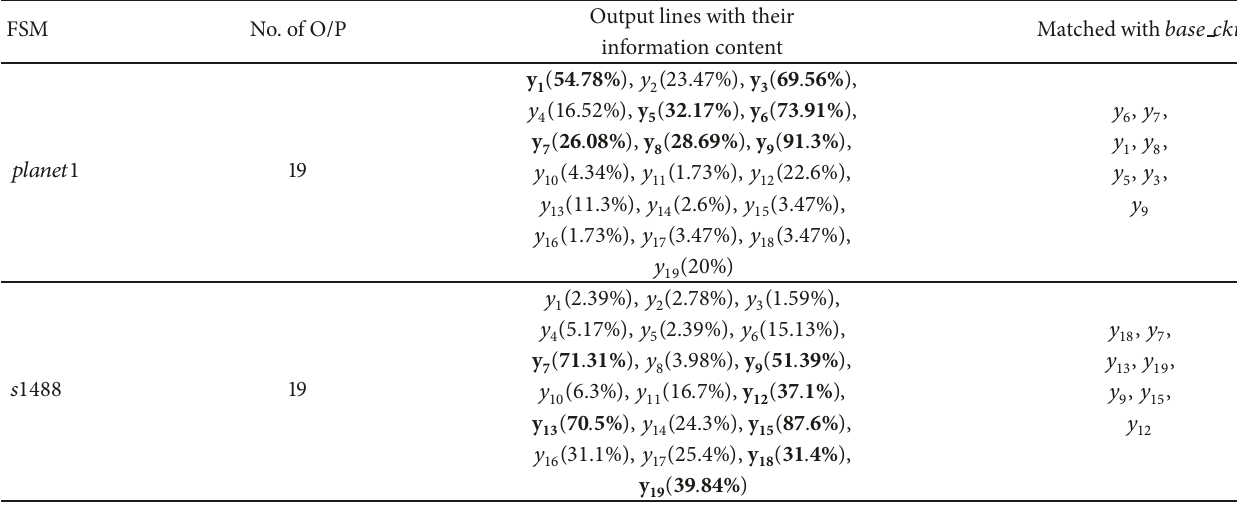
Matched with 𝑏𝑎𝑠𝑒 𝑐𝑘𝑡